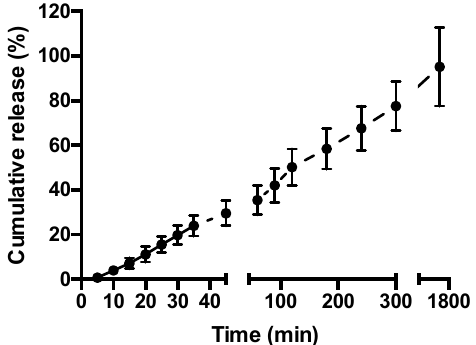
Figure 3. Fluorescein isothiocyanate-labeled bovine serum albumin (FITC-BSA) release from methylcellulose (MC)-hyaluronic acid (HA) hydrogel. FITC-BSA release was measured at 37 °C in Hank’s Balanced Salt Solution. Data shown as mean ± SD ( n = 3).